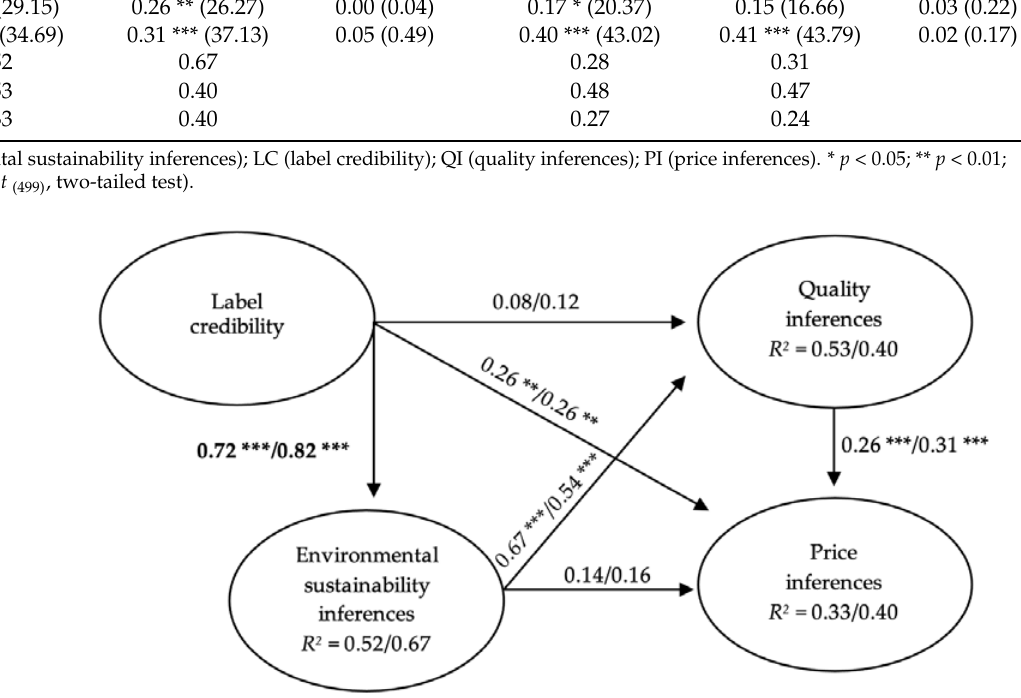
Figure 2. Structural model for the EU organic label (non-information/information). Note. Significant